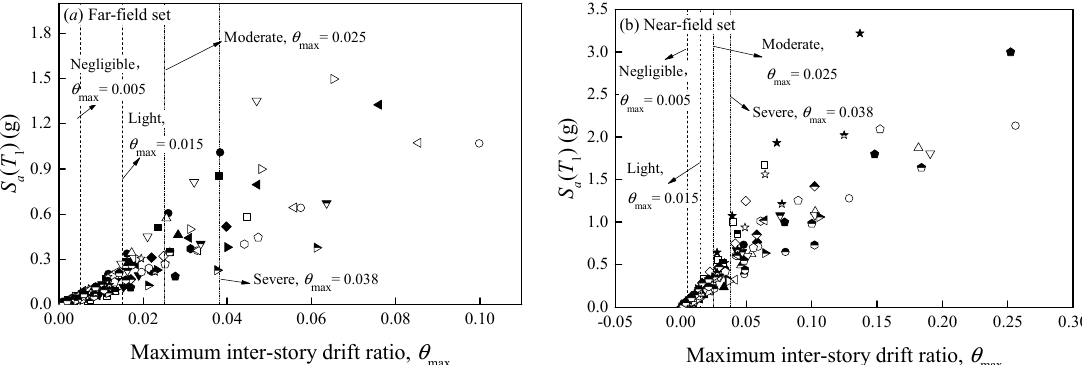
Figure 5. Discrete points θ max - Sa ( T 1 ) for both record sets.